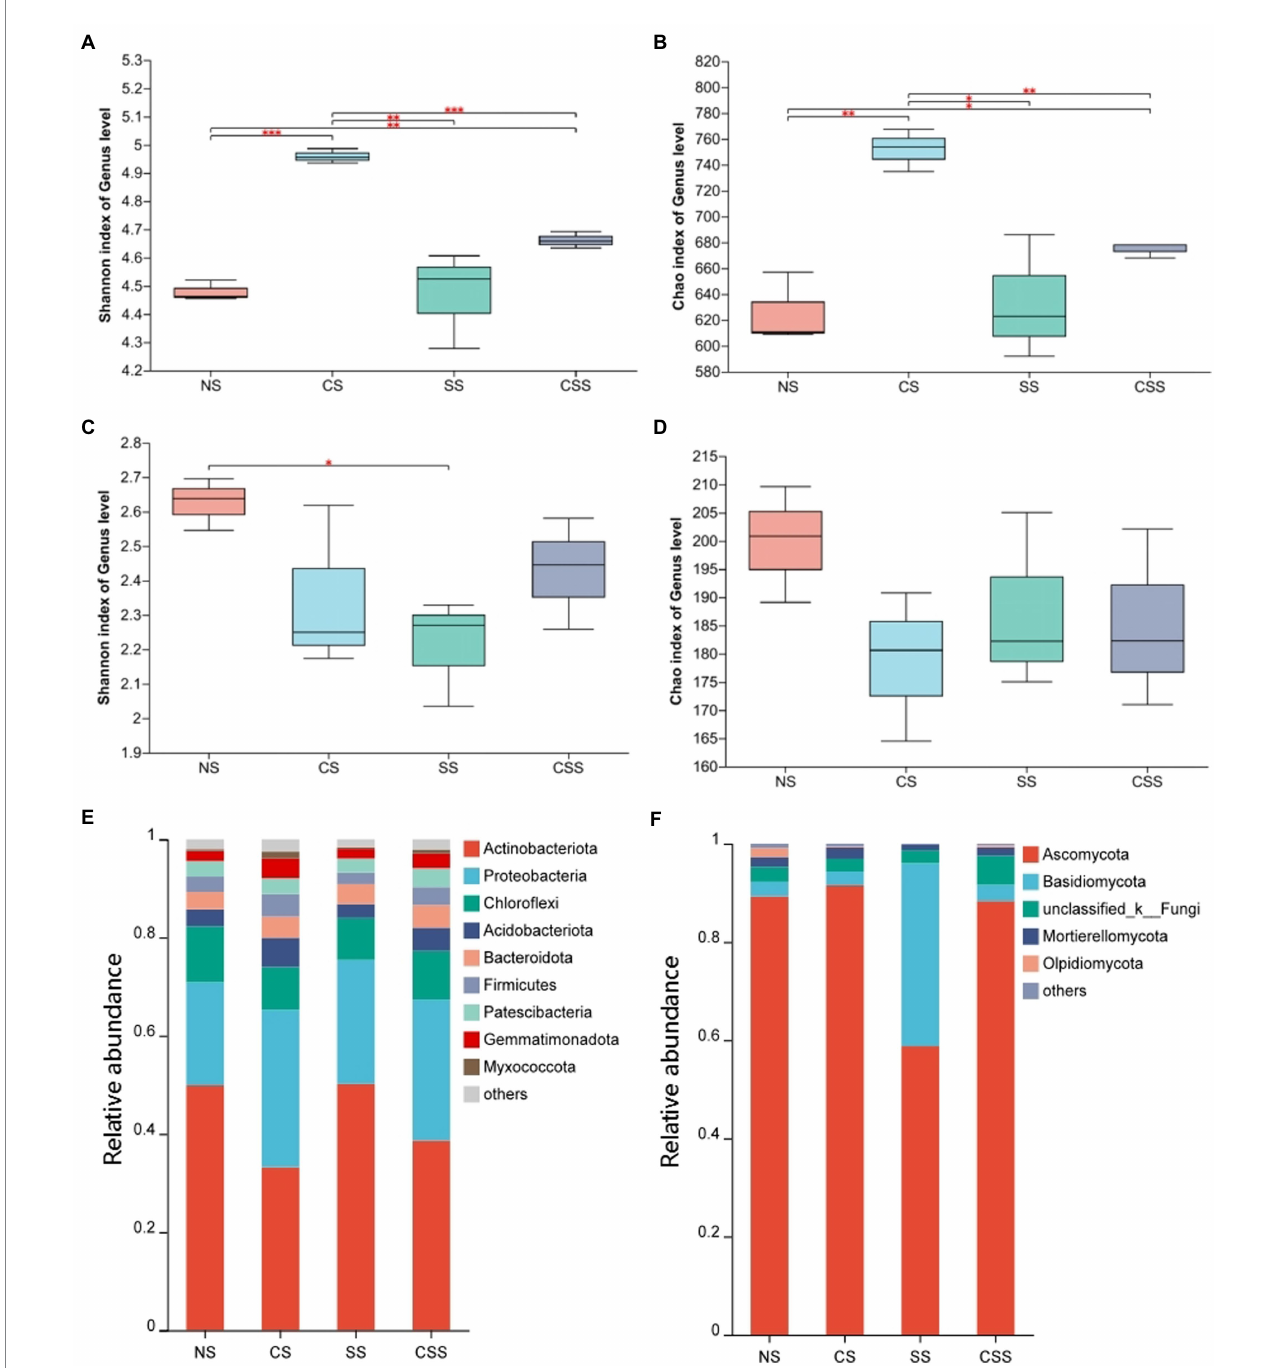
FIGURE 6 The diversity and composition of peanut rhizosphere microbiome. (A) Boxplot of soil bacterial diversity based on Shannon indices on the genus level; (B) Boxplot of soil bacterial richness based on Chao1 indices on the genus level; (C) Boxplot of soil Fungal diversity based on Shannon indices on the genus level; (D) Boxplot of soil Fungal richness based on Chao1 indices on the genus level; Differences between the means in each group were compared using a Wilcoxon rank-sum test (* p < 0.05, ** p < 0.01, and *** p < 0.001). The top and bottom whiskers indicate the maximum and minimum values, respectively, and the hyphen represents the median value; (E) Bacterial composition of soil samples at the phylum level. (F) Fungal composition of soil samples at the phylum level. NS, uninoculated soil; CS, Soil inoculated with Bacillus velezensis CB13; SS, Soil inoculated with Sclerotium rolfsii ; CSS, Soil inoculated with B. velezensis CB13 and S. rolfsii